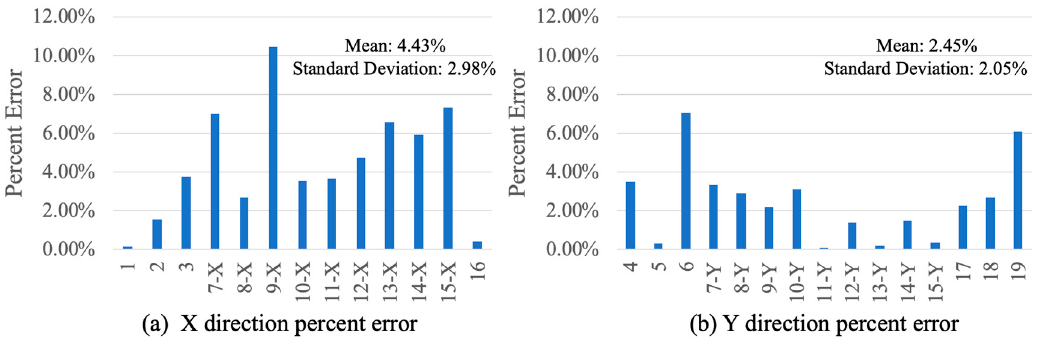
Figure 9. Percent error of two directions: ( a ) X direction; ( b ) Y direction.